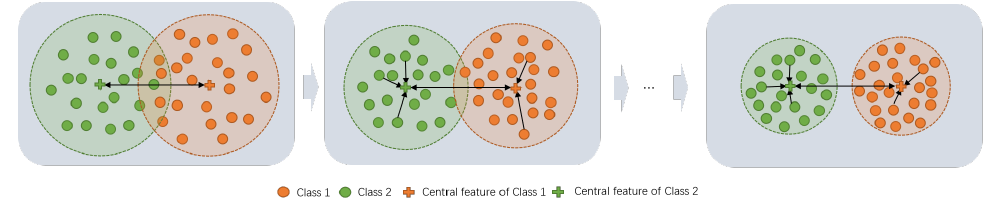
Figure 2. The principles of the proposed center loss and the central feature. The center loss drives the embedding features of each category to accumulate to the corresponding central feature c